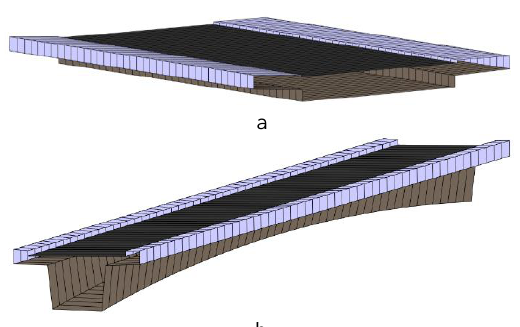
Figure 14. 3D models of the body: a: bridge 1; and b: bridge